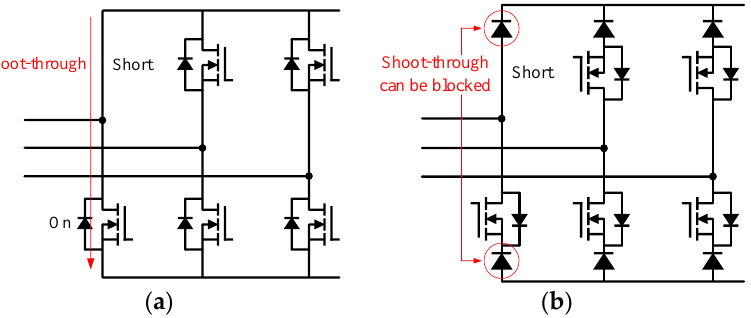
Figure 8. Shoot-through fault on bridge topologies: ( a ) boost-type rectifier, ( b ) buck-type rectifier.